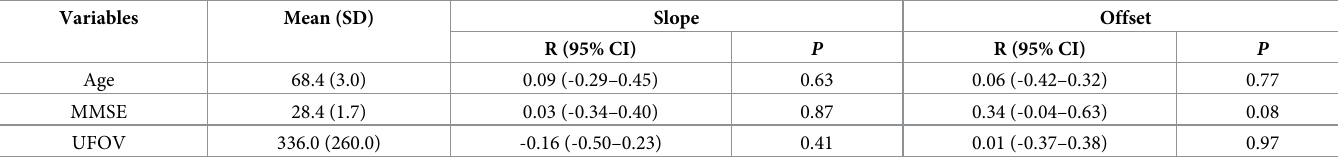
Table 4. Correlation coefficients between BOLD responses by parametric analysis and individual characteristics (n = 28). Variables